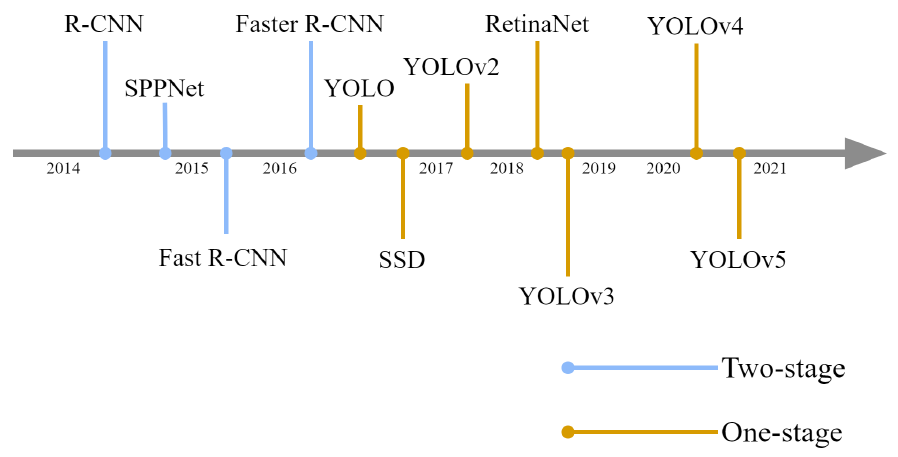
Figure 4. The evolution of deep learning-based target detection